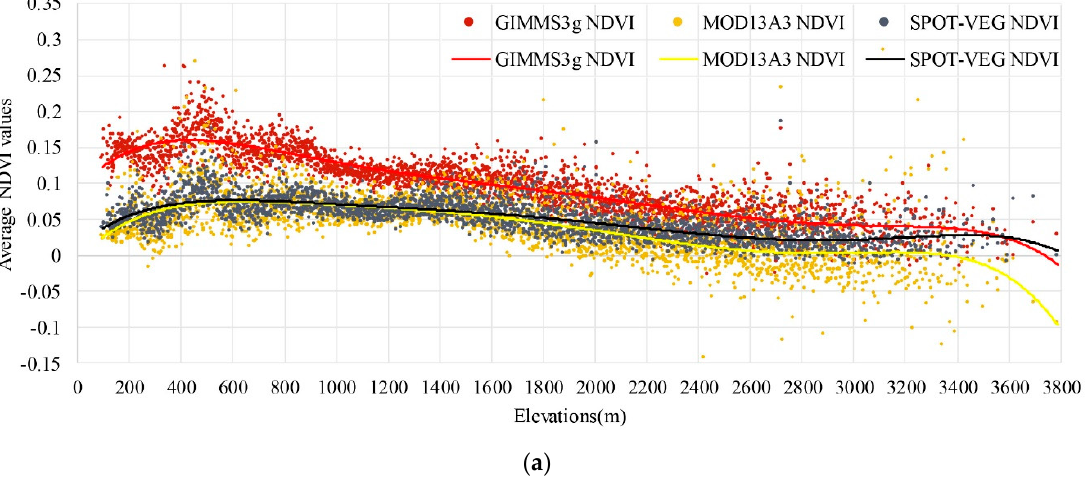
( b ) Figure 10. Scatter plots and fitting curves of average NDVI values at different elevations from 95 m to 3788 m in ( a ) January 2013 and ( b ) July 2013. 4. Discussion 4.1. Validation against Landsat-Based NDVI Based on the above results of the zonal differences of NDVI in the MP, 35 Landsat 8 images with very little cloud cover were selected to conduct the uniformity verification of the three NDVI datasets. Figure 11 presents the spatial distribution of the 35 Landsat 8 images in the MP, and the corresponding path/row and image date information for each Landsat 8 image are listed in Table 6. In order to analyze the consistency between Landsat 8-based NDVI and the other three NDVI datasets homogeneously, the 35 Landsat 8 images were resampled to the spatial resolution of GIMMS3g NDVI, MOD13A3 NDVI, and SPOT-VGT NDVI, respectively. Then, statistical scores were computed to describe the discrepancies between Landsat 8-based NDVI and the three NDVI products. Figure 12a shows the Pearson correlation coefficient between values of Landsat 8 NDVI and the corresponding three NDVI products. The mean values of the correlation coefficient between Landsat 8 NDVI and GIMMS3g NDVI, MOD13A3 NDVI, and SPOT-VGT NDVI are 0.57, 0.70, and 0.71, respectively. There